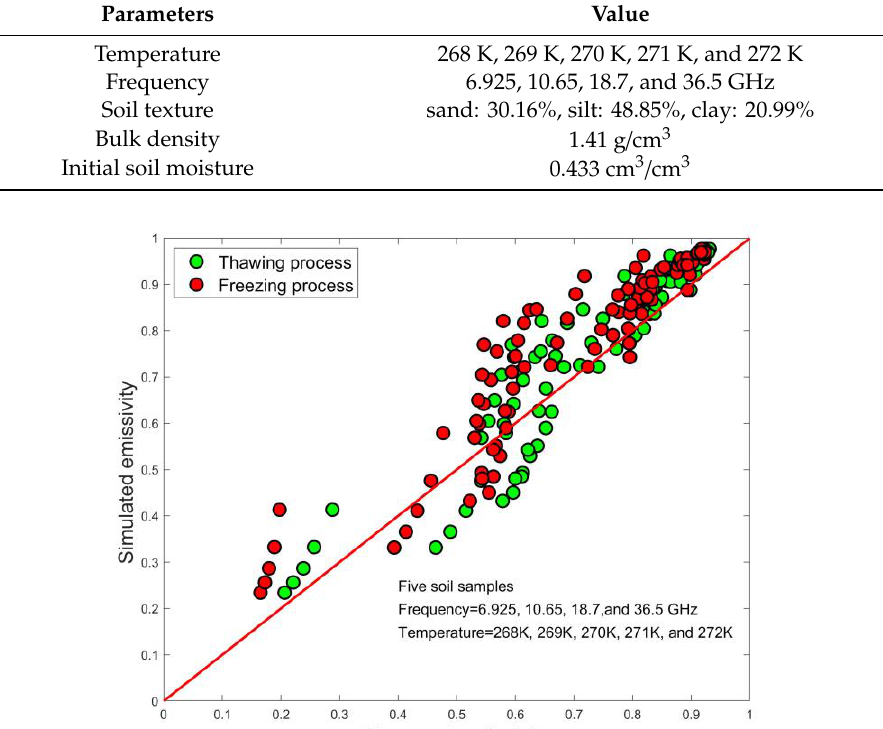
Figure 10. Comparison between measured and simulated emissivity using theoretical model during freezing and thawing processes.